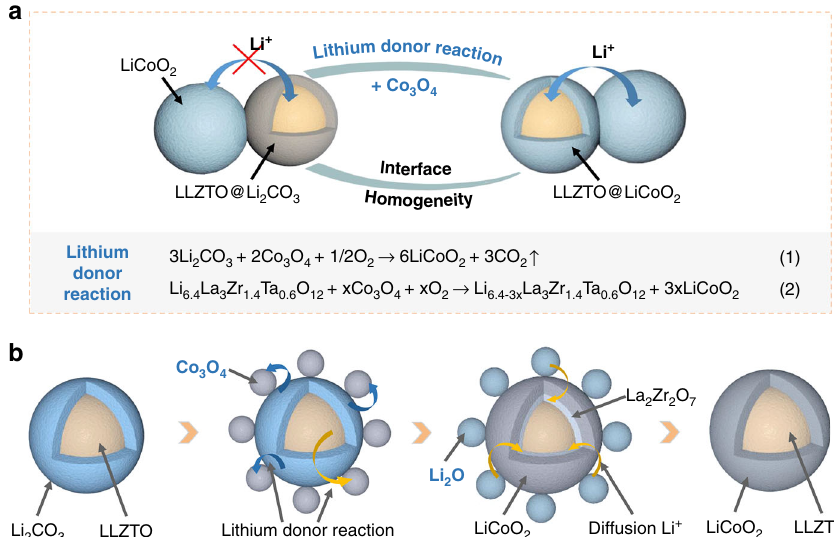
Fig. 2 Process of transforming LLZTO@Li 2 CO 3 into LLZTO@LCO. a Schematic illustration of the lithium-donor reaction to achieve interface homogeneity. b Schematic illustration of the two-step solid state reaction process of transforming LLZTO@Li 2 CO 3 into